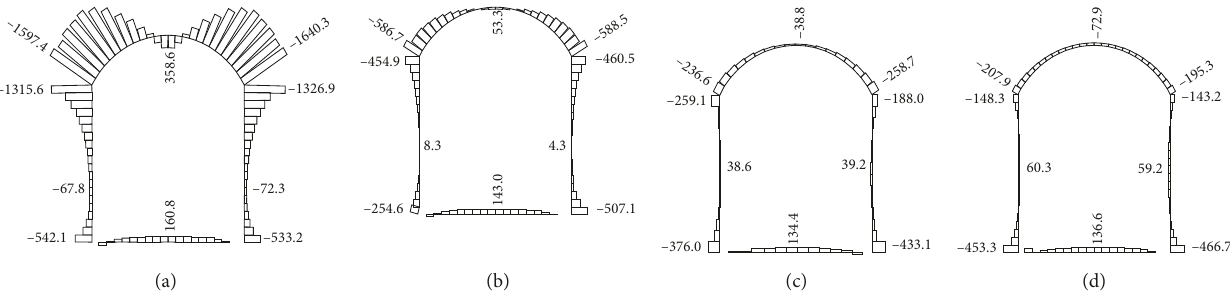
Figure 10: Diagram of axial forces in sprayed concrete layer with different fault distance cases: (a) 0.2 spans; (b) 0.5 spans; (c) 1.0 span; (d) no fault.